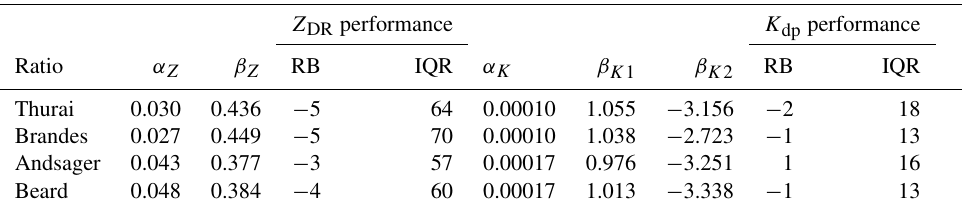
Table 5. Fitted coefficients and the performance of the fits on the training data, for Eqs. (17) and (18), by raindrop axis ratio function (Ratio). Performance is shown in terms of median relative bias (RB, %) and the IQR (%pts) of relative bias. Z DR performance